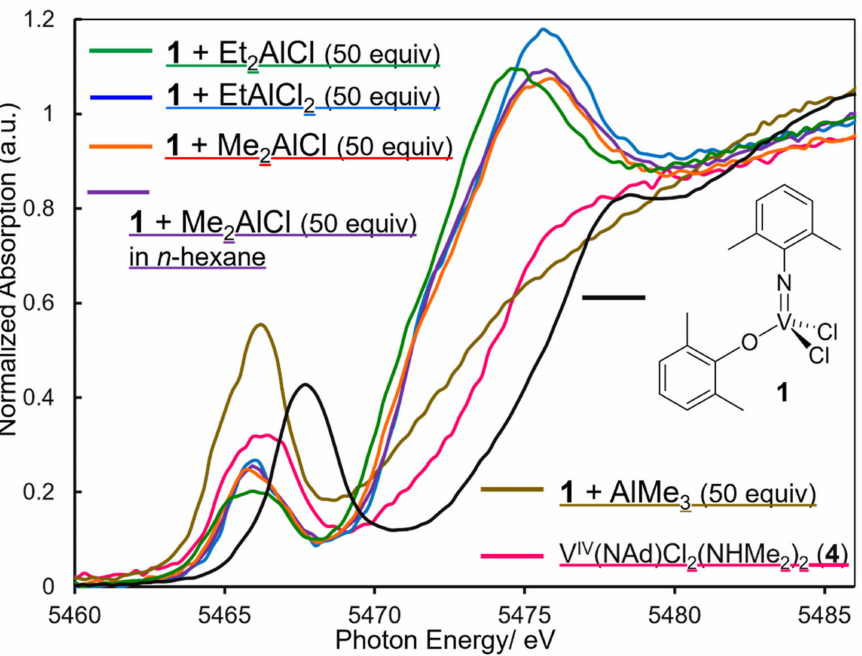
Figure 3. The V K-edge XANES spectra for V(NAr)Cl 2 (OAr) ( 1 , Ar = 2,6-Me 2 C 6 H 3 ) in the presence of Et 2 AlCl, Me 2 AlCl, EtAlCl 2 , and AlMe 3 (in toluene or n -hexane at 25 ◦ C). The similar low-energy shift in the pre-edge absorption was observed with increase in the intensity when 1 was treated with 50 equiv of AlMe 3 (5466.2 eV). The clear